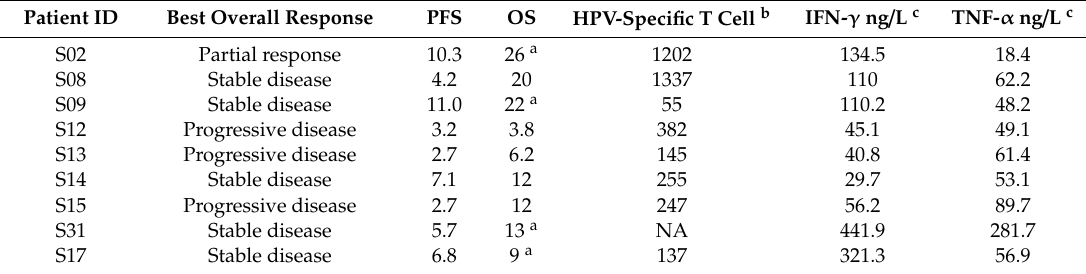
Table 3. Best overall response as assessed by the investigator review according to irRC ( n = 9) and immune response induced by BVAC-C